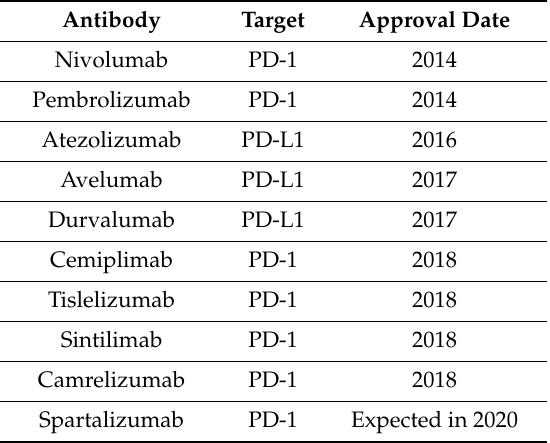
Table 1. Approved PD-1 / PD-L1 checkpoint